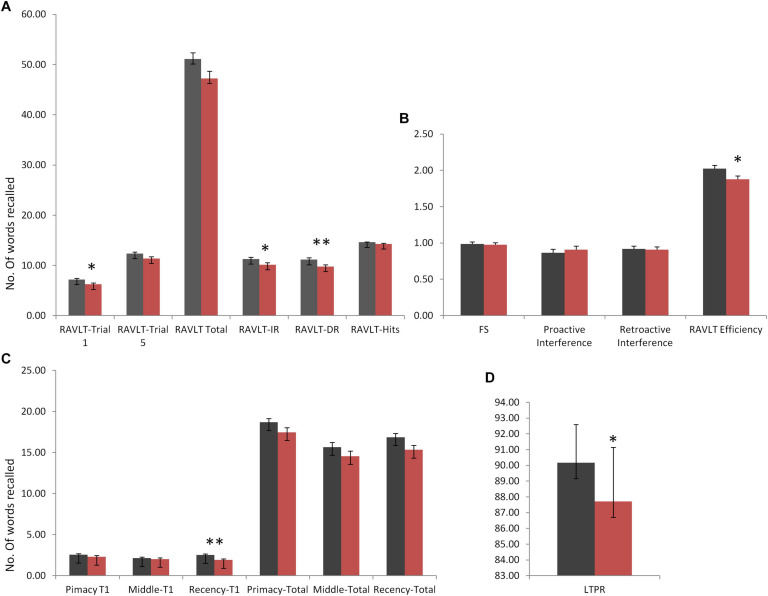
Rey Auditory Verbal Learning Test (RAVLT) data represents trends of verbal memory impairment in Duchenne muscular dystrophy (DMD) subjects. (A) A significant difference in trial 1, immediate and delayed verbal memory. (B) No difference was observed in the susceptibility to interferences through proactive interference (PI) and retroactive interference (RI) scores. RAVLT-Memory Efficiency Index (MEI) was found to have cut-off values close to the patients of behavioral variant frontotemporal dementia (bvFTD). (C) Among serial positioning factors, recency T1 score was found to be reduced significantly. (D) Long-term percent retention of DMD subjects was also affected. All results expressed as mean ± standard error of mean (SEM). Data was statistically analyzed using SPSS 16.0 by independent t-test/non-parametric test (Mann–Whitney test) as applicable. *p < 0.05, **p < 0.01, ***p < 0.001.